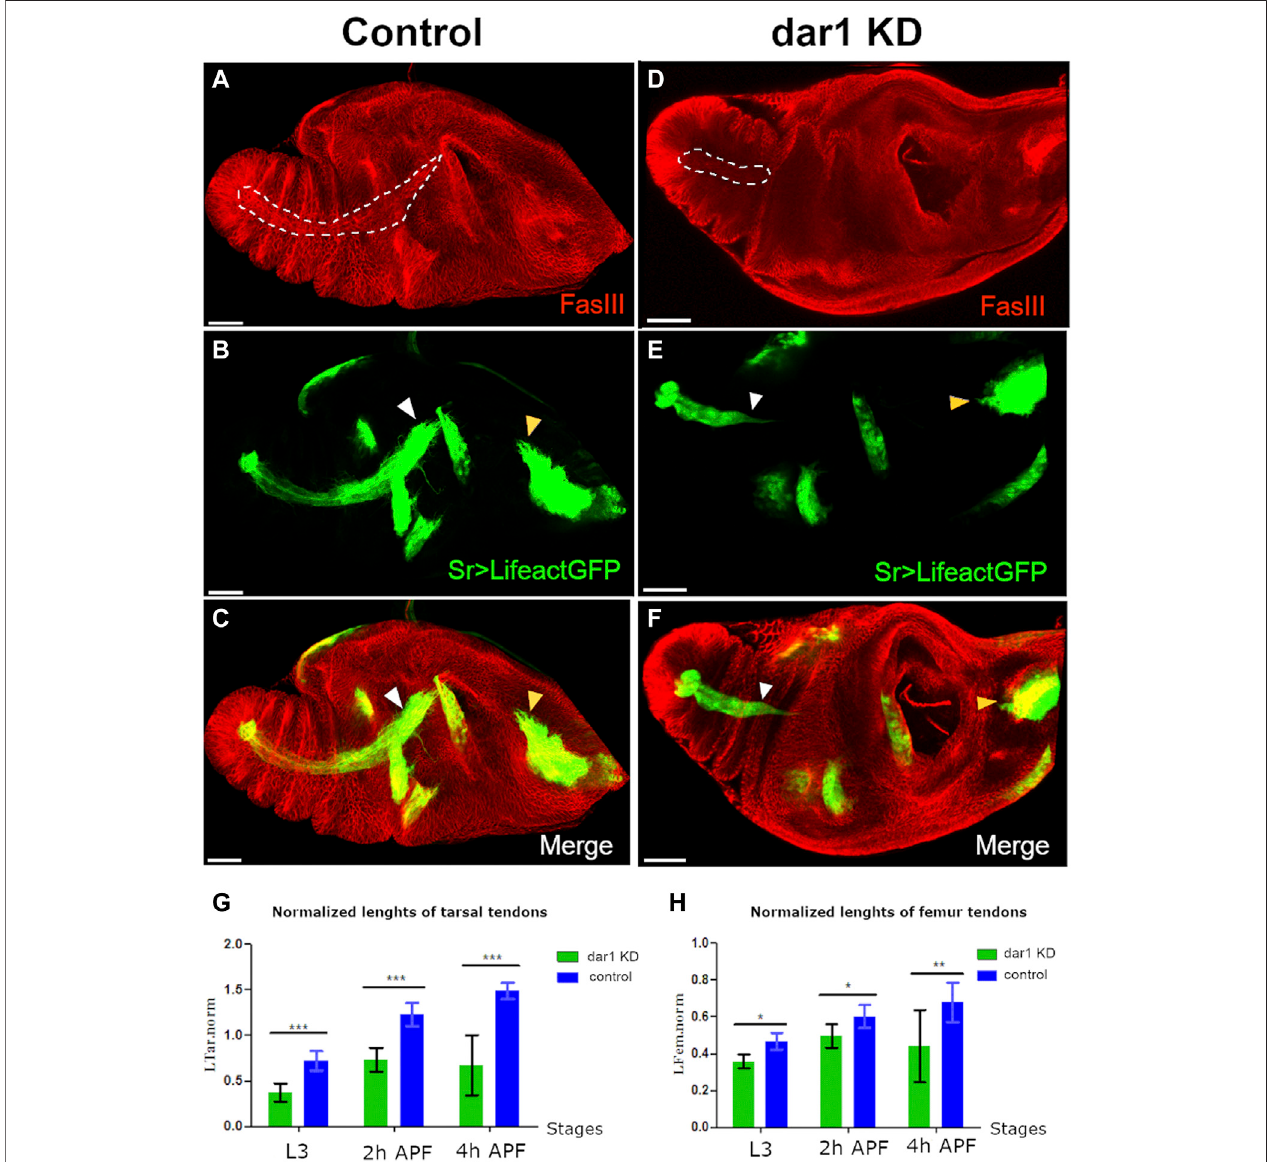
FIGURE. 4 | Dar1 is required for the elongation of long tendons. Confocal images of sr-gal4,dar1 3010/+ > UAS-Lifeact.GFP (A – C) and sr-gal4,dar1 3010/+ > UAS- Lifeact.GFP,UAS-dar1RNAi (D – F) legdiscsat 3 h APF immunostained withanti-fasIII. Onthis optical section, thelong elongating tendon ofthetarsiis revealed byUAS- Lifeact.GFP and FasIII (dashed line A and D). In dar1 KD leg disc (D – F) , the tarsal lt appears much shorter than in the control (white arrowheads in B,C and E,F). At this stage of development, other tendons are less elongated than the one in the tarsi and therefore their difference in length between control and dar1 KD is not as obvious,except forthetilt inthedorsal femur (yellowarrowheadinB,Cand E,F),whichalso appears shorter (G,H) Graphsshowingthelengthsoftheltintarsi(G)and tilt femur(H)incontrollegdiscsversusand dar1 KDlegdiscatthreetimepoints:lateL3(control n (cid:2) 11, dar1 KD n (cid:2) 11),2 hAPF(control n (cid:2) 10, dar1 KD n (cid:2) 17)and4hAPF (control n (cid:2) 5, dar1 KD n (cid:2) 5). Error bars represent s.d.; * p < 0.05, ** p < 0.01 and *** p < 0.001 (Bonferroni test). Scale bar 40 μ m.